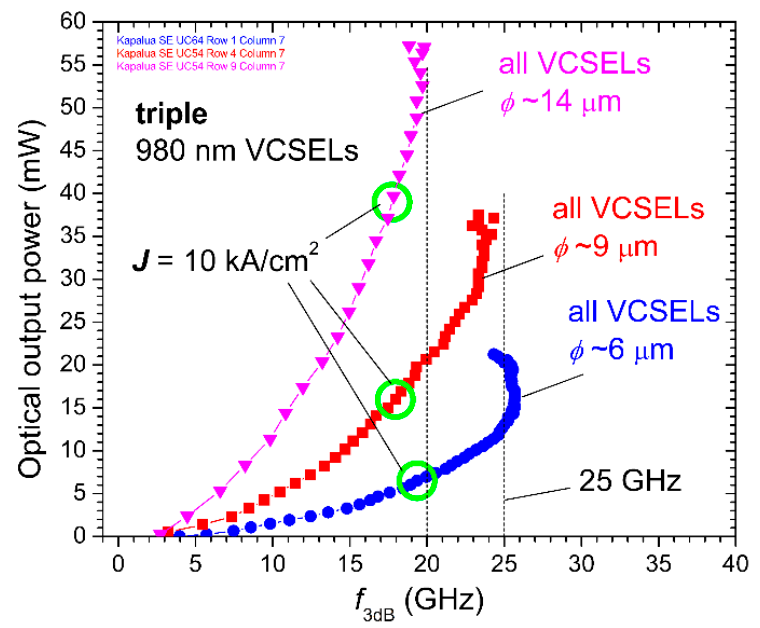
Figure 12. Extracted f 3dB versus static optical output power ( L ) for 980 nm triple VCSEL arrays with φ ~6 µ m (blue circles), φ ~9 µ m (red squares), and φ ~14 µ m (magenta triangles). The green circles indicate the points where the bias current density J = 10 kA/cm 2 .